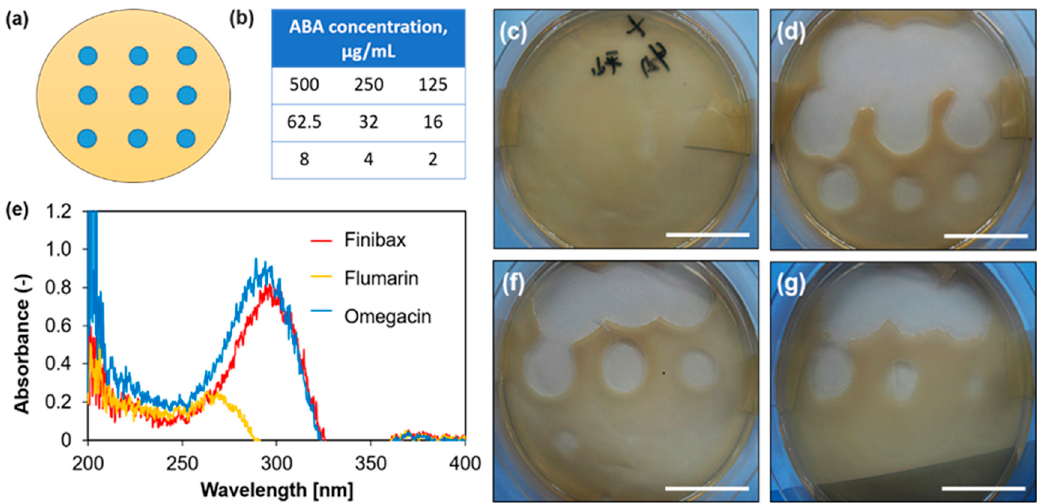
Figure 1. Descriptions of the images of the experiment: ( a ) The dropped position of the antibacterial agent (ABA) solutions in a dish; ( b ) the ABA concentrations: 2–500 µg/mL on the point; and ( e ) the spectral wavelength of the antibacterial agents, namely Finibax, Flomoxef, and Biapenem. Photographs of the action of the ABAs in a dish of transformed Escherichia coli: ( c ) control or ABA-free; ( d ) Finibax; ( f ) Flomoxef; and ( g ) Biapenem after 1 day of the inoculation. The bar represents 30 mm.